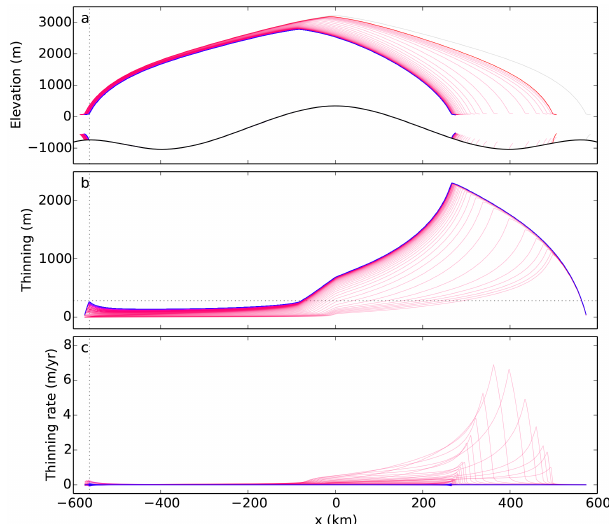
Figure 11. Same as Fig. 10 but here for the stable scenario S (sim- ulation